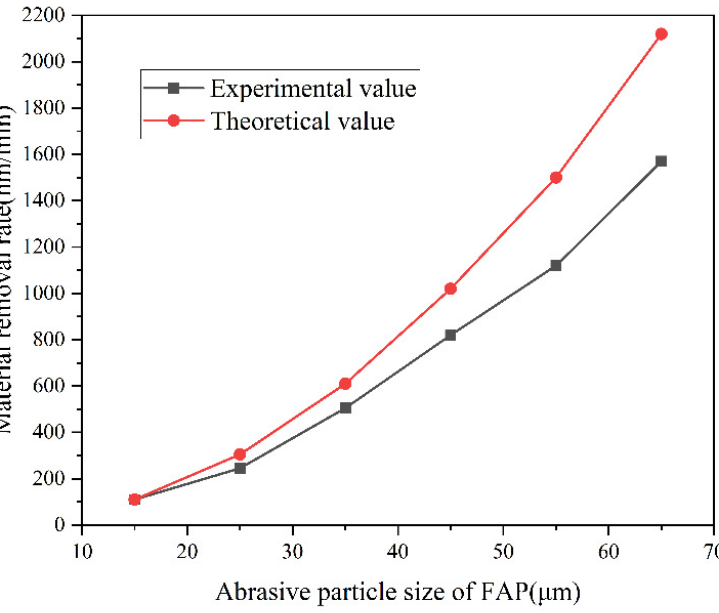
Figure 7. Comparison of experimental and theoretical results of material removal rate. After the experiment, the surface roughness of the workpiece was measured five times at any part of the sampling length of 1500 µ m, and the average value was calculated as the final value of the average workpiece surface roughness. In Figure 8, it can be seen that with the increase in the diamond abrasive particle size on the FAP, the theoretical values and experimental values of the surface roughness of the workpiece after machining maintained an approximate linear increasing trend. For the FAP containing larger abrasive grains, the diamond abrasive grains were exposed to a larger height on the surface. The exposed diamond scratched and plowed the surface of the workpiece more significantly and was more likely to leave deep scratches, material collapse, and broken pits, on the surface of the workpiece, causing the surface roughness of the workpiece to increase. In addition, since the depth of cut of the diamond abrasive grains used in the theoretical calculation was greater than the actual value, the elastic deformation of the sapphire workpiece during the grinding process was ignored in the model. As a result, the experimental value of surface roughness of the sapphire workpiece machined by a fixed diamond abrasive pad with the same particle size was less than the theoretical